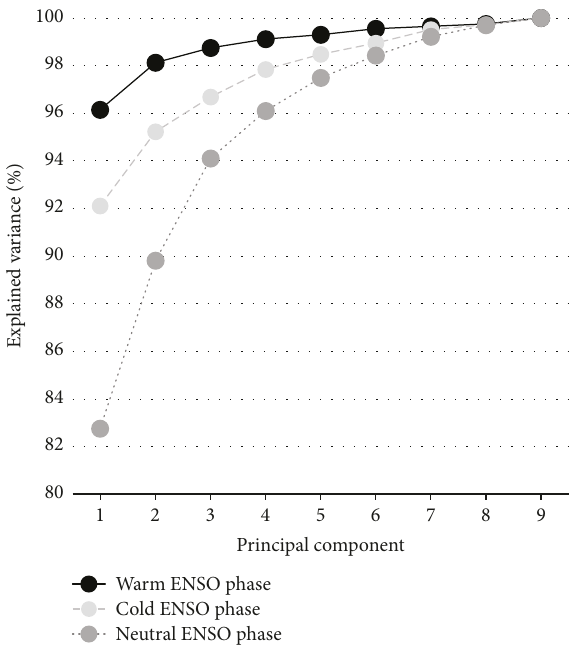
Figure 8: Principal components and their explained variances for the ENSO phases.